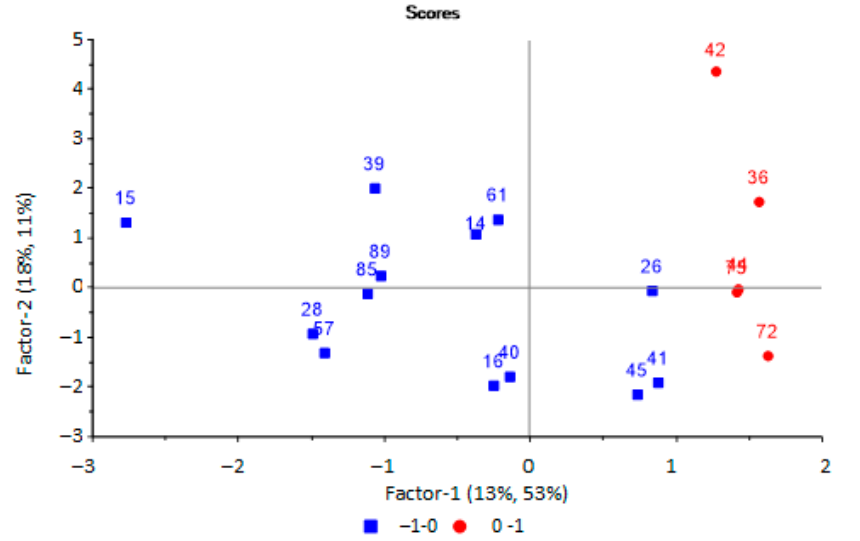
Figure 6. Scores plot of the PLS model for predicting the microbiological contamination of urine samples based on the results of analysis of samples by an array of sensors.